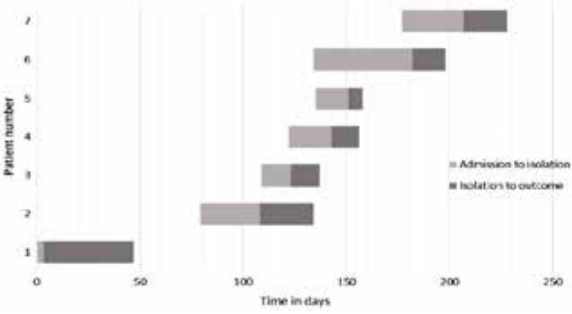
Figure 1: Timeline demonstrating day of isolation of VRE in relation to period of admission in the seven patients admitted to HU.